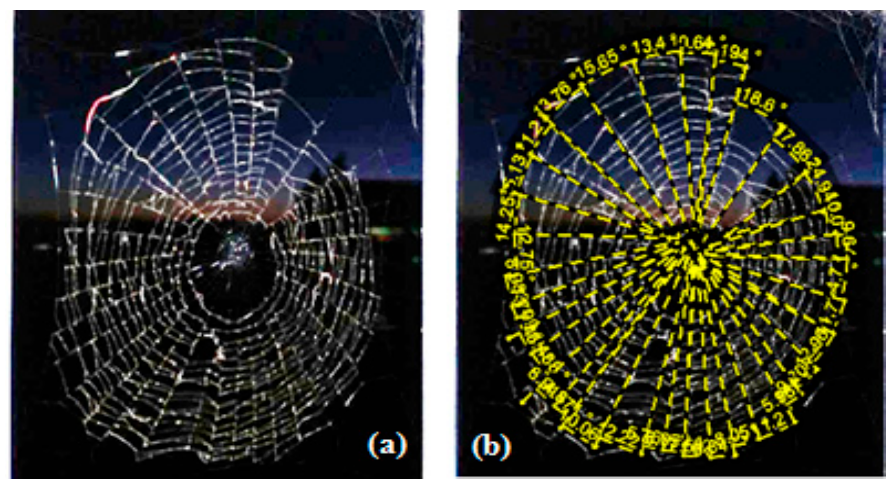
Figure 5. ( a ) Unmeasured image ( b ) measured image of SP4.